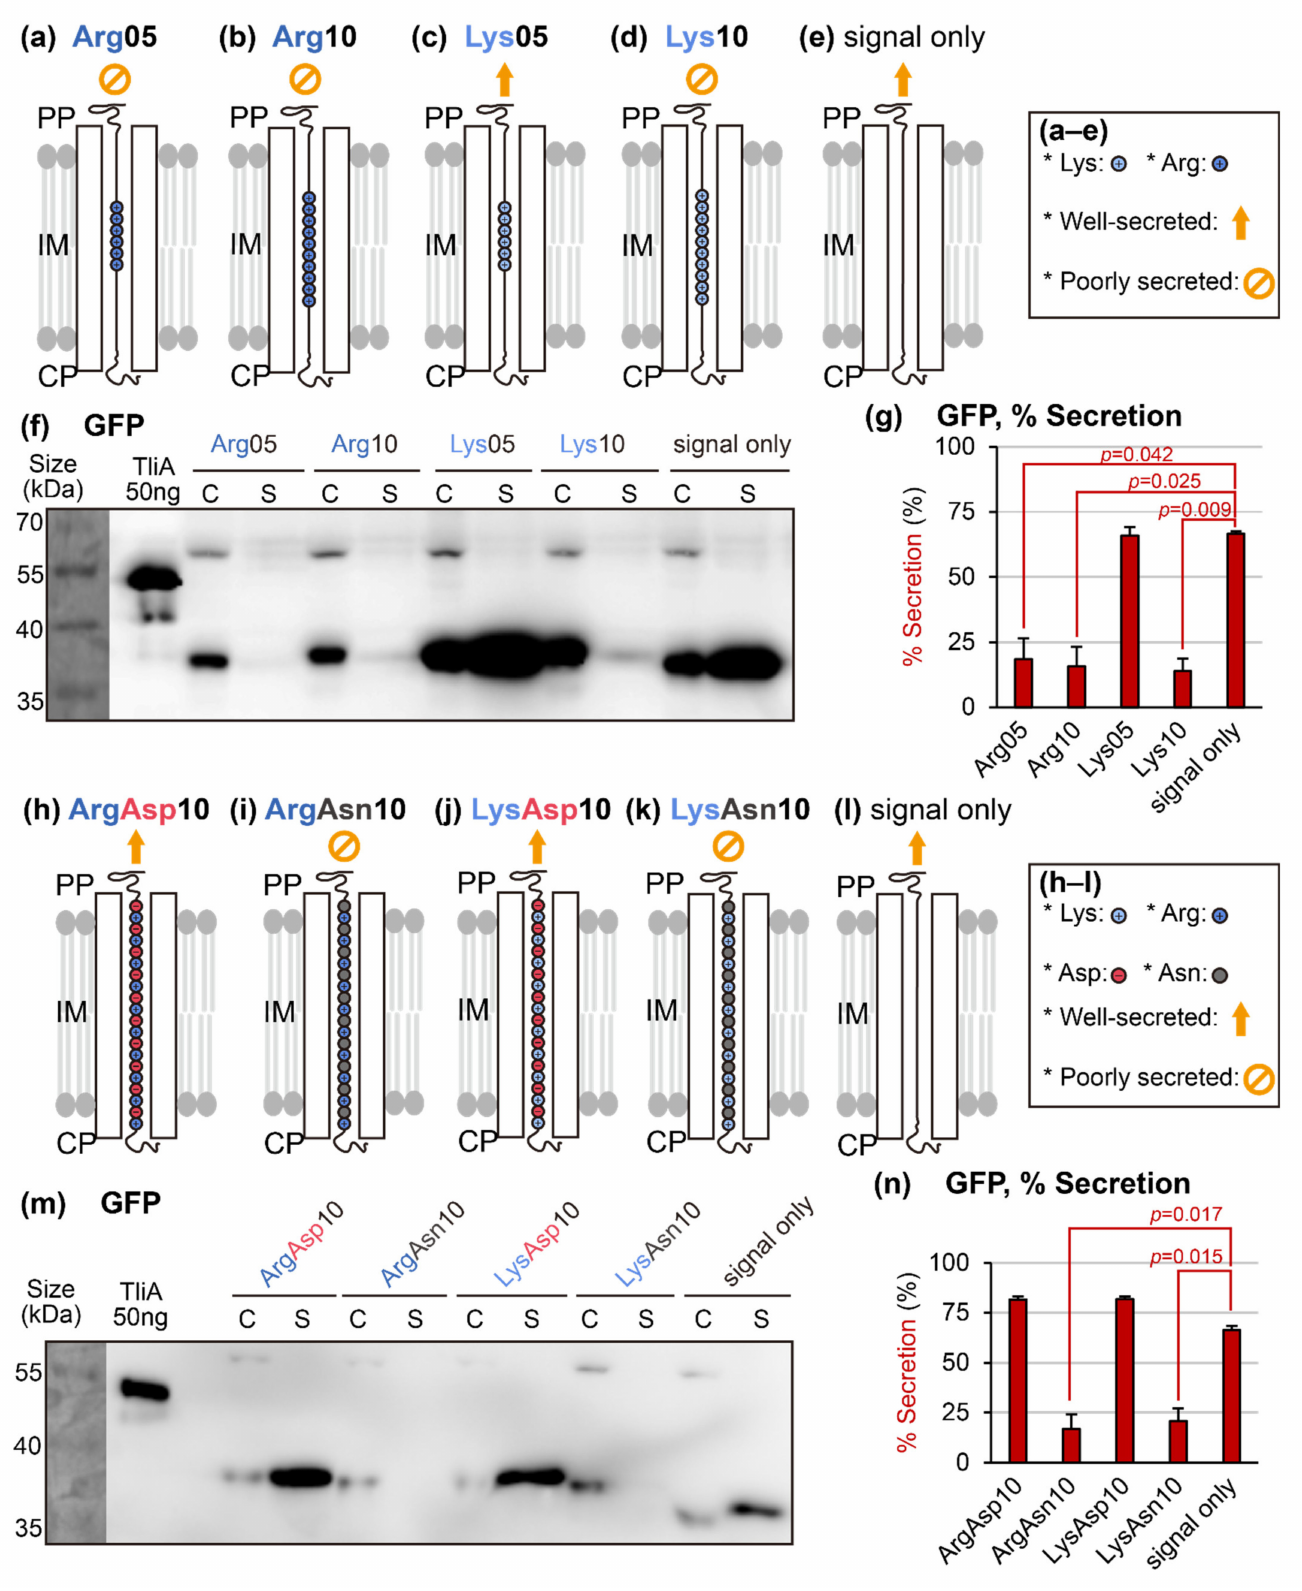
Figure 3. Investigation of secretable conditions by ABC transporters. ( a – e ) Structures of the con- structed artificial cationic supercharged regions consisting of consecutive cationic amino acids, Arg05, Arg10, Lys05, and Lys10. Yellow arrows indicate that the protein was secreted, while